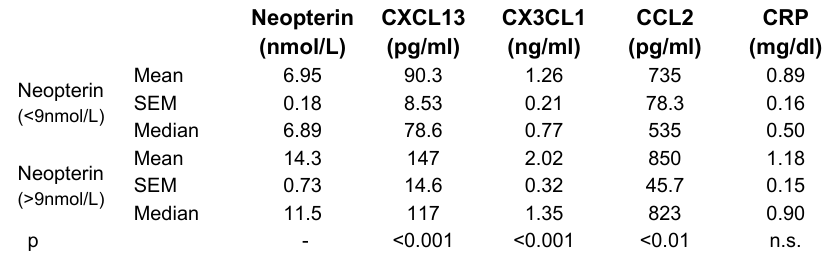
Table 3: Chemokines concentrations in patients grouped accorrding to their neopterin concentrations; Group 1 with low neopterin levels < 9 nmol/L, Group 2 with high neopterin levels > 9 nmol/L). (total n = 113) Mean = arith- metic mean value, S E M = standard error of mean, Median = geometric mean value, p = significance, ns = not significant.